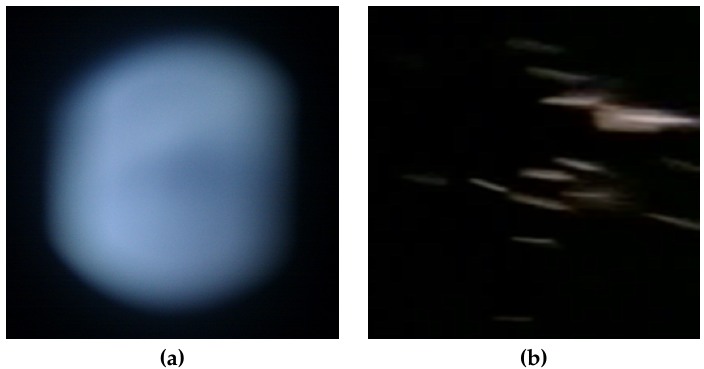
Figure 5. ( a ) Scatter blob [29] vs. ( b ) individual scatter traces, for illustrative purposes both at high particle